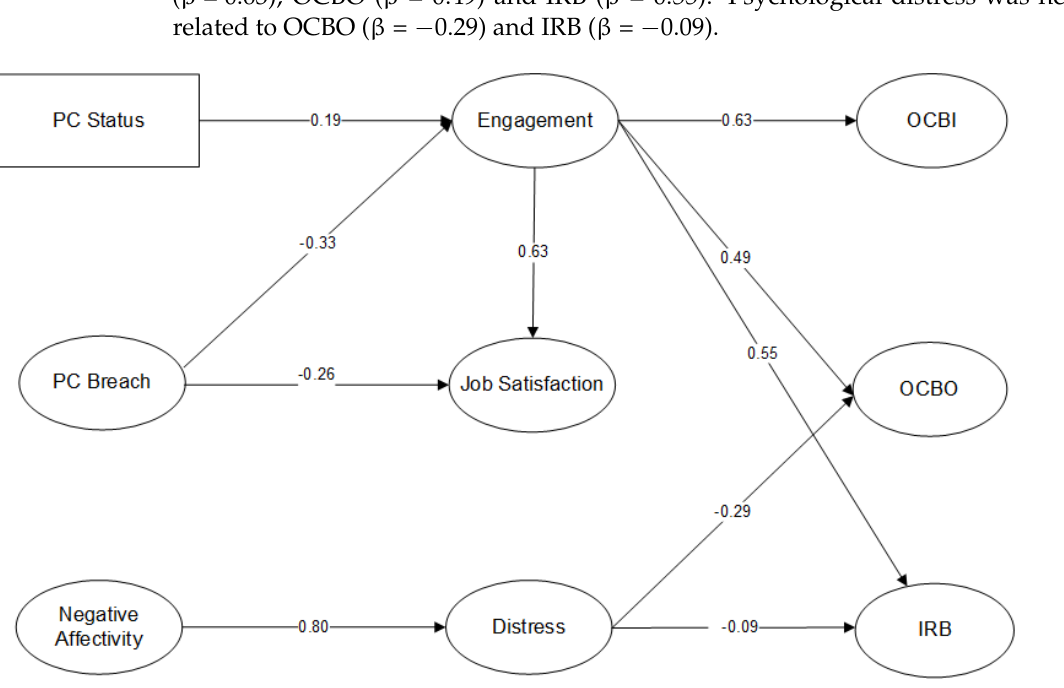
Figure 1. The structural equation model of the significant relationships among the aspects of the psychological contract, via mediators, onto extra-role and in-role performance behaviors.